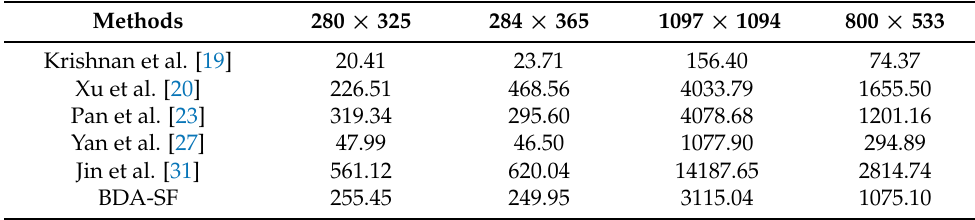
Figure 20. Deblurred results and its corresponding intermediate results over iterations. With the Sigmoid function, the proposed BDA-SF achieves intermediate results containing more sharp edges. The use of the Sigmoid function makes the results contain sharper edges and texture features. Table 3. Runtime (in seconds) of different methods. The code is implemented in